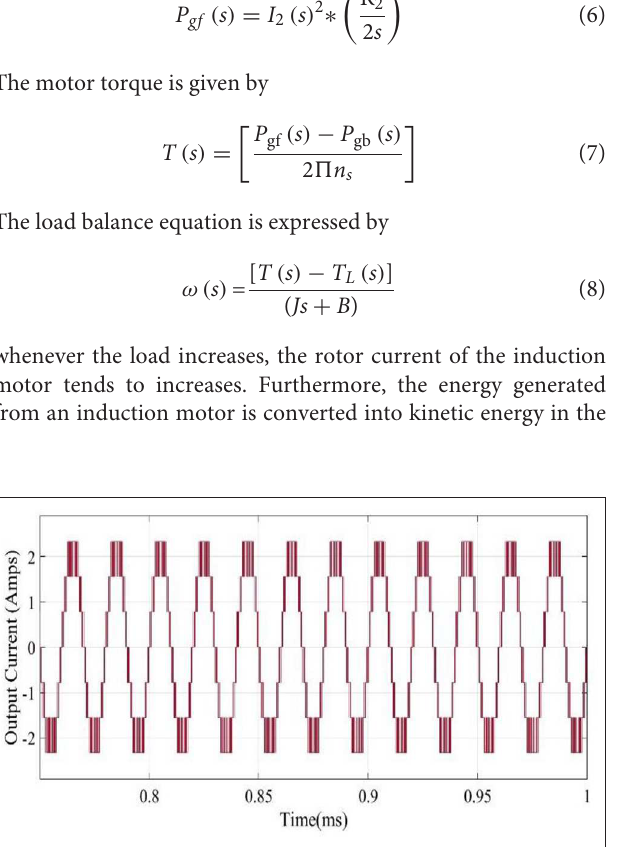
FIGURE 7 | Output current from seven-level inverter with five switches.